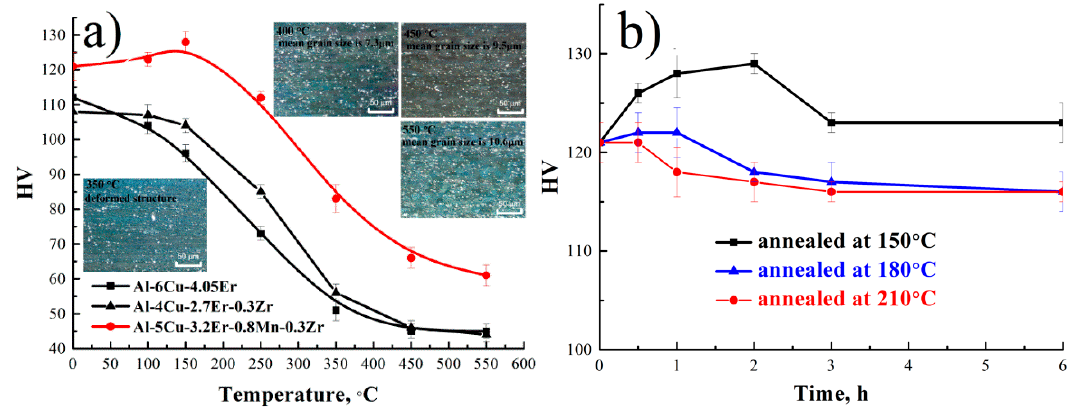
Figure 5. HV vs. ( a ) temperature and ( b ) time curves of the annealed alloy after rolling.